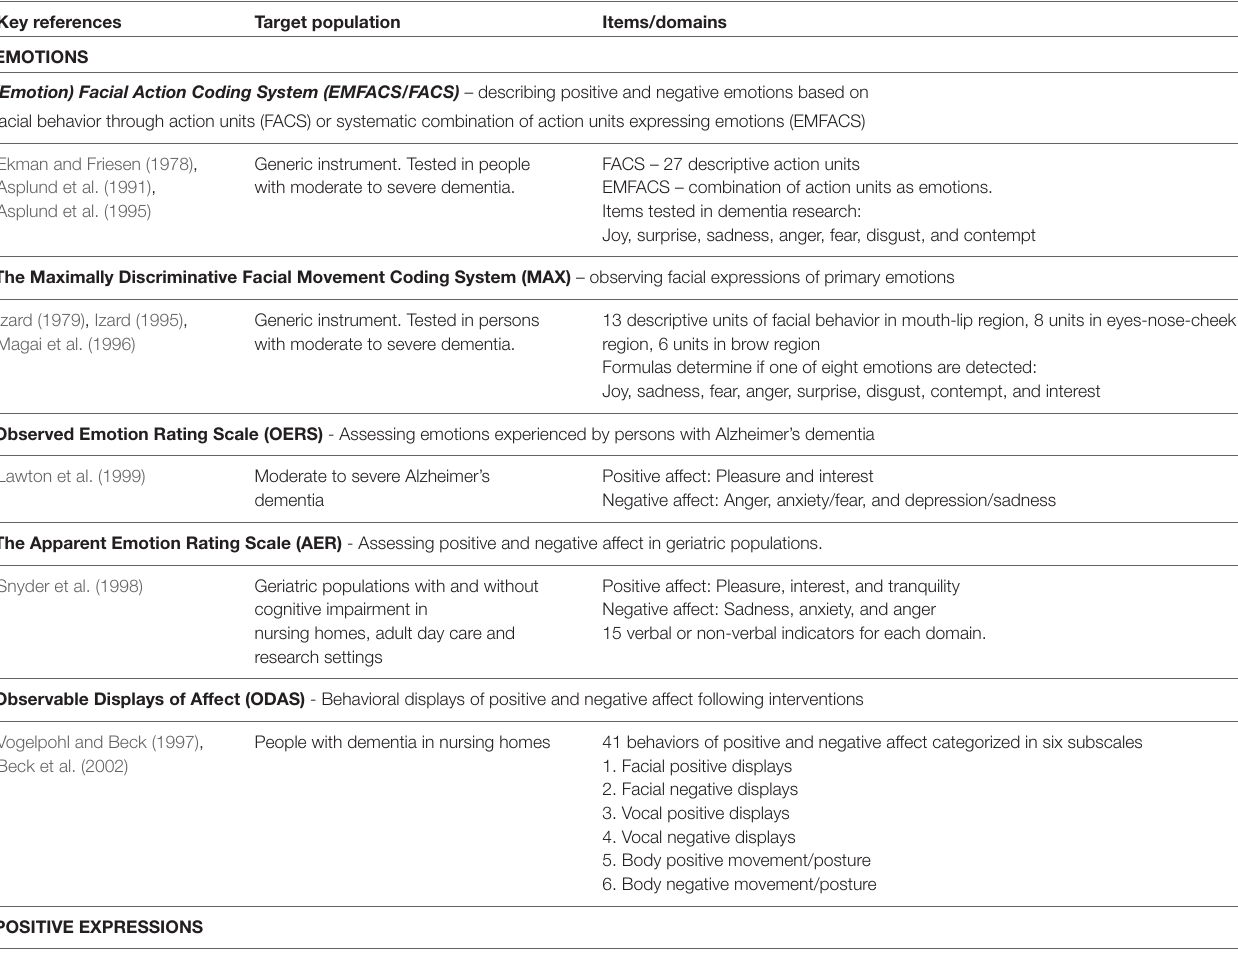
TABLE 3 | Characteristics of the included